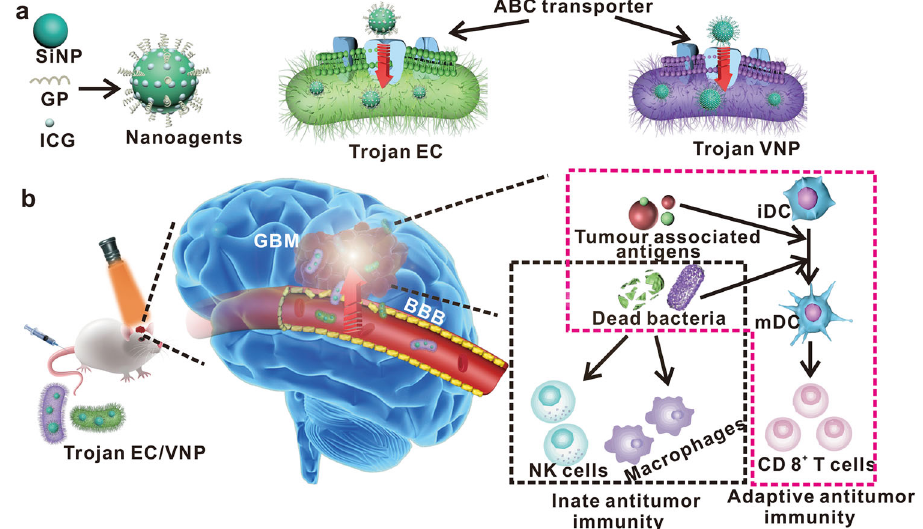
Fig. 1 | Schematic illustration of Trojan bacteria crossing blood – brain barrier forphotothermalimmunotherapy ofglioblastoma.a A scheme illustrating the construction of Trojan bacteria system. The nanoagents composed of silicon nanoparticle (SiNP) modi fi ed with glucose polymer (GP) (e.g, poly[4-O-( α -D- glucopyranosyl)-D-glucopyranose] ) and indocyanine green (ICG) were inter- nalized into bacterial cells (e.g., attenuated Salmonella typhimurium VNP20009